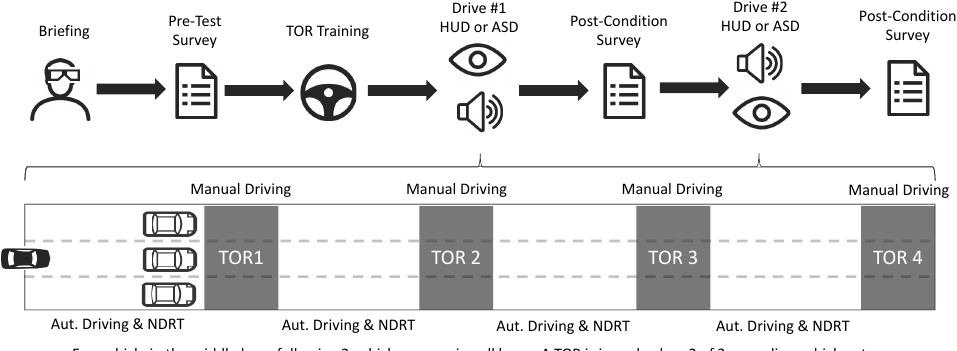
Figure 1. Driving simulator study procedure involving the two randomized conditions HUD and ASD (top), with 4 automated driving and 4 take-over phases per condition